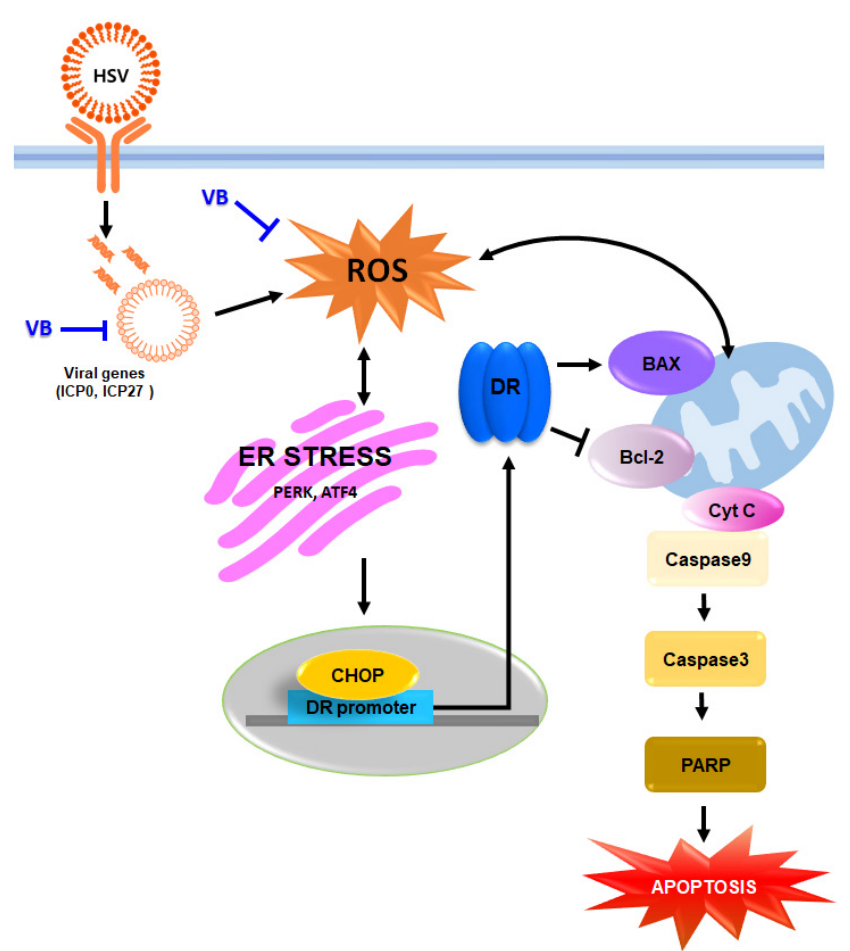
Figure 8. We propose an antiviral mechanism of VBT by HSV-1 infection in SK-N-SH cells. VBT exhibits an antiviral effect through the inhibition of IE expression by HSV-1 infection. Furthermore, VBT, which exhibits antiviral effects, protects SK-N-SH cells through the regulation of ROS-ER stress-mitochondrial apoptosis mechanism.